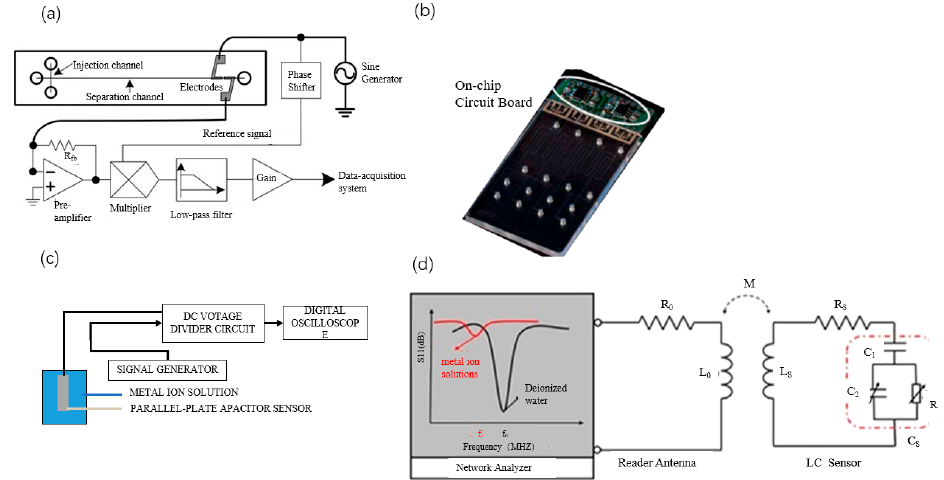
Figure 6. ( a ) CE microchip and detection circuit [88], ( b ) four-channel microchip and non-contact conductivity detector [89], ( c ) experimental setup of a parallel plate capacitive sensor [90], and ( d ) wireless micro fl uidic sensor based on LTCC technology [91].